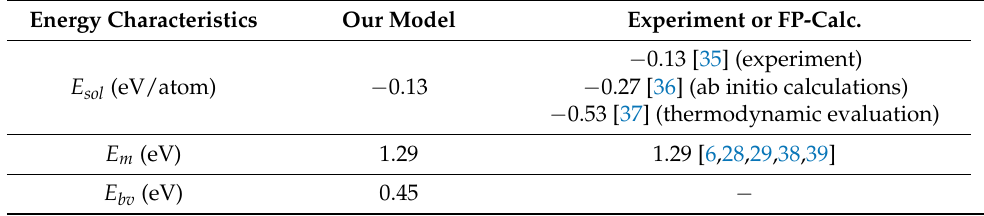
Table 2. Some energy characteristics of nitrogen impurity in f.c.c. iron.